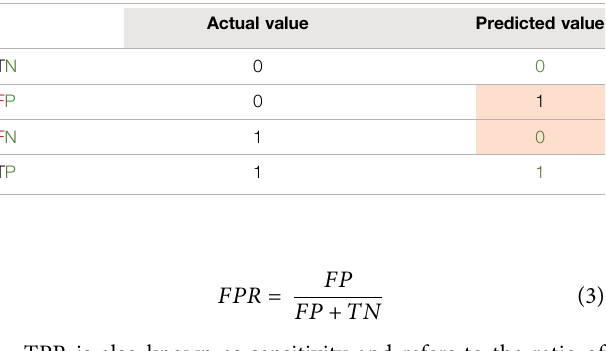
TABLE 1 | Possible outcomes of binary classi fi